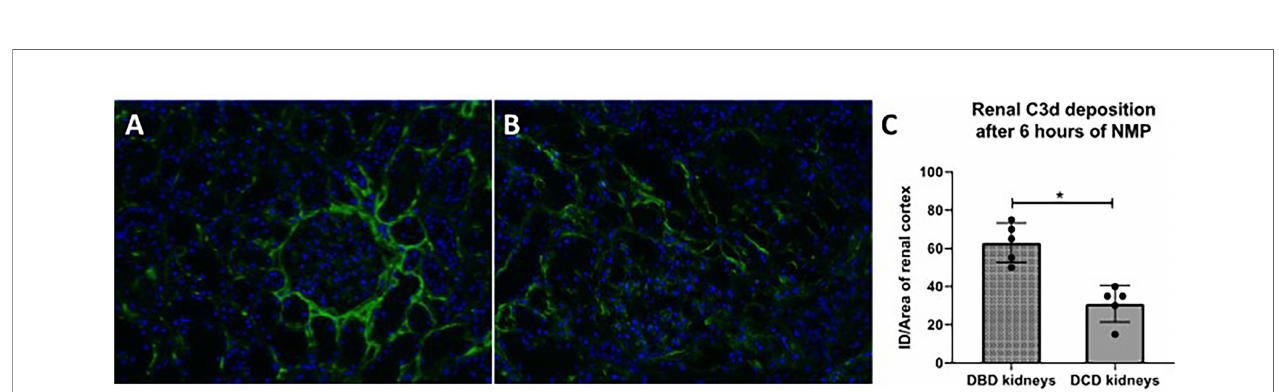
FIGURE 9 | C3d deposition in human discarded kidneys after 6 h of normothermic machine perfusion. Confocal microscopy of human discarded kidneys procured from (A) brain-dead donor and (B) a circulatory death donor after 6 h of normothermic machine perfusion. (C) Difference in C3d deposition after 6 h of normothermic machine perfusion in kidneys derived from brain-dead versus circulatory death donors. Nuclei were counterstained with DAPI. Original magni fi cation ×100. DBD, donation after brain death; DCD, donation after circulatory death. ID, immuno fl uorescence density; NMP, normothermic machine